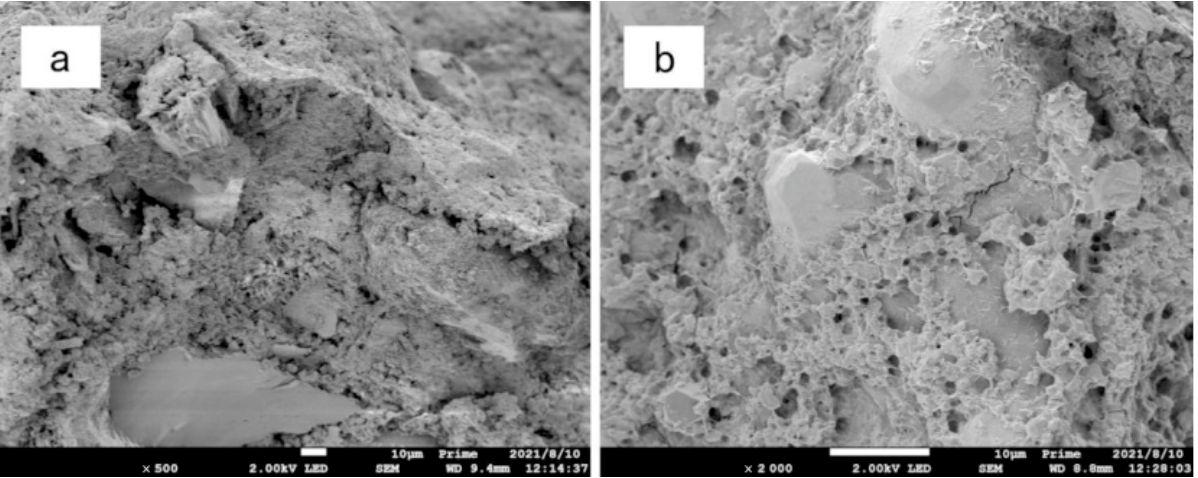
Figure 13. Electron microscopic image of the sample modified by 12%PVA + 8% active magnesium oxide without dry–wet cycle. ( a ) 500-fold magnified ( b ) 2000-fold magnified oxide without dry–wet cycle. ( a ) 500-fold magnified ( b ) 2000-fold